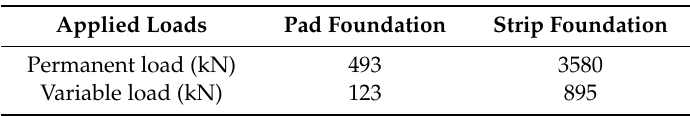
Table 4. Loads applied on shallow